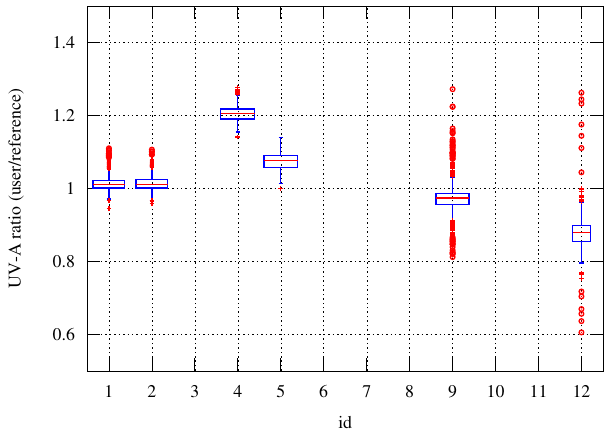
Fig. 9. Boxplot of UV Index ratios between each instrument and the reference, calculated under all sky conditions (both cloudy and clear days). The clear-sky simulations (id 14) were not considered in the analysis.